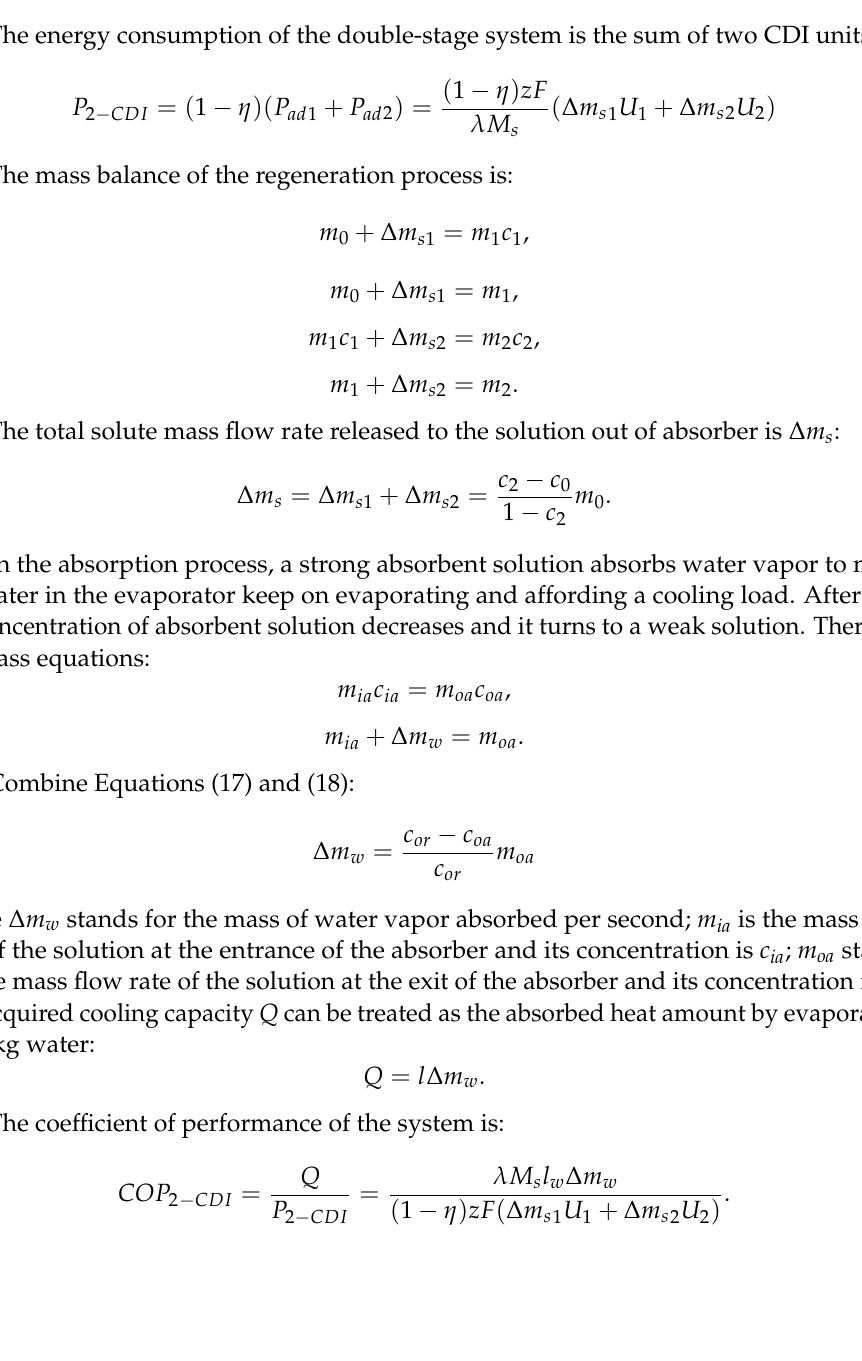
Figure 4. Mass relationship of double-stage system.